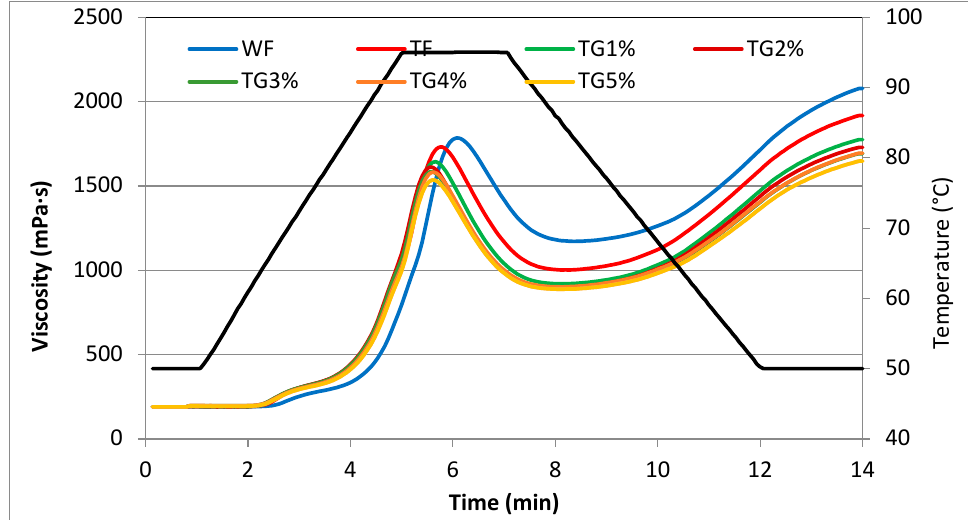
Figure 1. Pasting curves of wheat fl our, triticale fl our and system of triticale fl our with vital gluten. The gelatinization temperature of wheat fl our (Table 3) was higher in comparison to TF and its TG mixtures. The addition of vital gluten to TF did not have a statistically sig- ni fi cant e ff ect on the gelatinization temperature. However, Ribo tt a et al. [23] showed that the gelatinization temperature of mixtures of wheat starch with soy protein isolate signif- icantly decreased as the share of SPI in the mixture increased. According to the quoted authors, the change in the PT of the system under the in fl uence of protein addition can also be a tt ributed to the increase in the e ff ective concentration of starch in the continuous phase, because the hydration and dissolution of soy protein occurs with increasing tem- perature. At the same time, the presence of fat and proteins that bind amylose, making it di ffi cult for it to pass into solution, may increase the gelatinization temperature of starch [23]. Similarly, Ga ł kowska et al. [19], examining the mixtures of corn starches with di ff er- ent levels of amylose content with potato protein (PP), found a decrease in the value of PT as the share of PP increased in all the analyzed systems. According to the cited authors, this is related to the lower resistance of starch in mixtures to the swelling process. Thus, in the systems, the amount of protein was too low to limit access to water for starch [19]. The main component of starch responsible for the swelling power and viscosity during heating is amylopectin. On the other hand, amylose, especially in the presence of lipids, tends to intertwine with amylopectin and thus reduces the swelling and dissolution of starch grains [25]. The gelatinization temperature of triticale starch contained in the tested fl our systems depends on the content of non-starch components. The rheological proper- ties of starch are strongly in fl uenced not only by the presence of naturally occurring frac- tions, but also by the presence of added foreign substances such as mineral salts, sugars or other hydrocolloids [23,26,27]. The maximum viscosity of the starch system at a speci fi c concentration is a measure of the ability of starch granules to swell freely before their physical disintegration [28]. The value of the maximum viscosity of the tested pastes ranged from 1536 mPa·s (TG5%) to 1784 mPa·s (WF). The PV value in the mixtures de- creased statistically signi fi cantly as the share of vital gluten (G) increased. The average value of this parameter for the TG mixtures was 1594 mPa·s and was 8% lower compared to TF. This was probably due to the decreasing share of starch mainly responsible for the viscosity of the paste. Nevertheless, Ribo tt a et al. [23] observed a signi fi cant increase in the viscosity of pastes with the participation of SPI (10–50%). According to the cited au- thors, proteins contain many di ff erent hydrophilic groups, all of which are capable of forming cross-links with starch polymers. Thus, the resulting cross-links may be respon- sible for the higher viscosity of the protein-blend paste compared to that of the native starch. In turn, Ga ł kowska et al. [19] observed an increase in PV in the tested corn starch